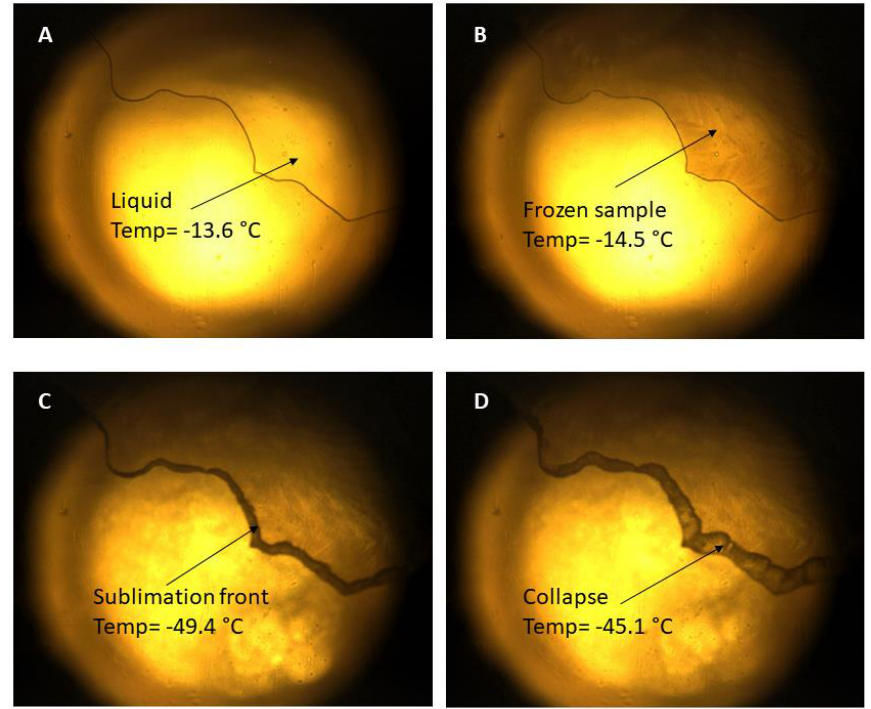
Figure 2. FDM pictures of a drop of DEX-lipomers (no cryoprotectant) showing different thermal events: ( A ) liquid sample; ( B ) freezing; ( C ) sublimation front; ( D ) collapse temperature.